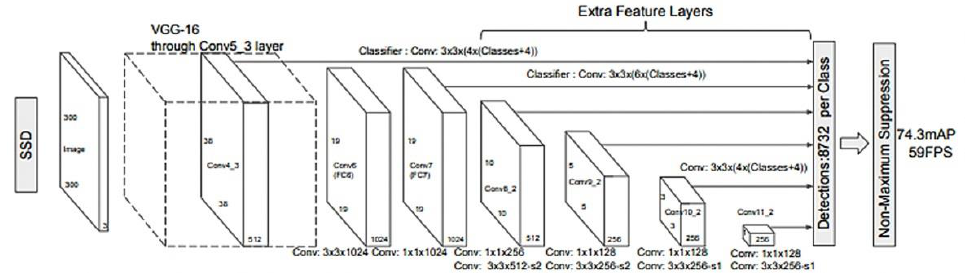
Figure 3. SSD deep learning model [43].